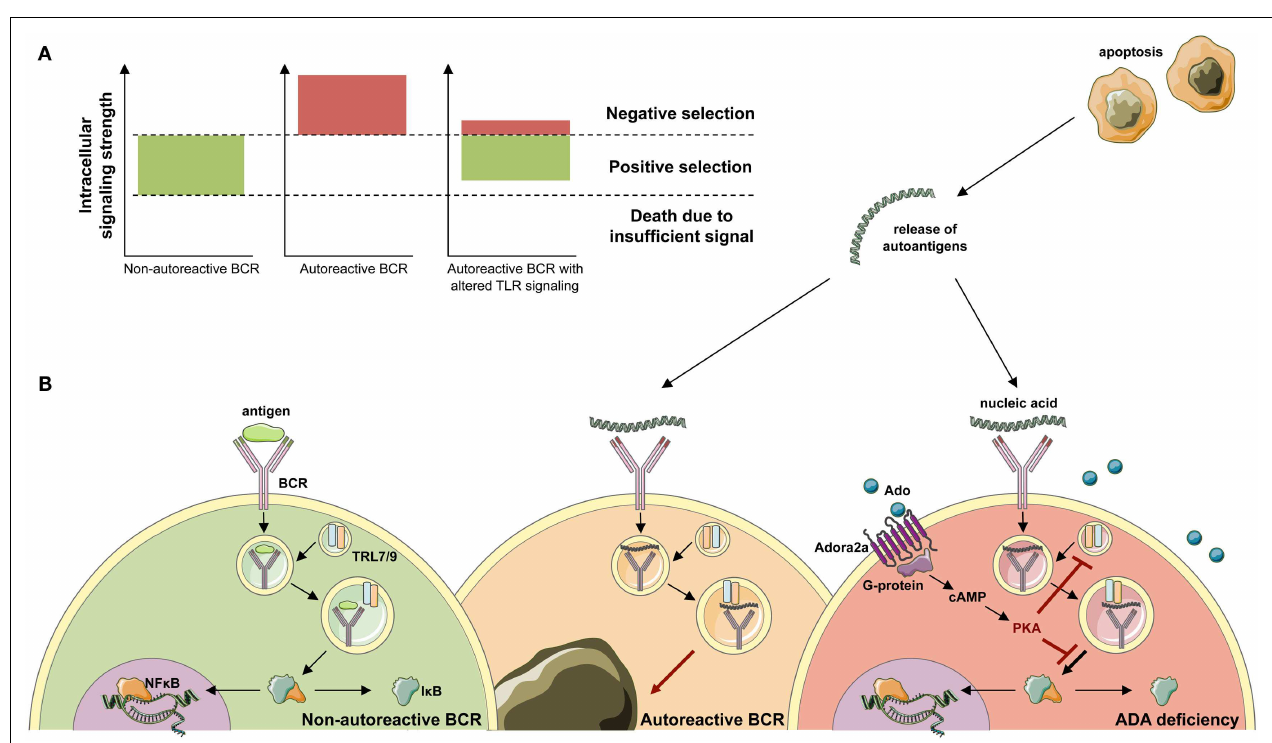
cell development and function. During the bone marrow differentiation of B cells, a major source of autoantigen is developing lymphocytes, which undergo apoptosis. Autoantigens are released in the extracellular space and form immune complexes. Binding of nucleic acid-containing immune complexes to an autoreactive BCR produces a strong activation signal through simultaneous activation ofTLRs and leads to the depletion or receptor editing of the B cell. It can be hypothesized that in ADA deficiency this negative selection is dampened by adenosine present in the extracellular place and engagement of the Adora2a. Activation of Adora2a elevates intracellular cAMP through activation of adenylyl cyclase. In turn, cAMP activates PKA that blocks the BCR-induced phosphorylation of I κ B to inhibit immunoreceptor-mediated NF- κ B activation in the cytoplasm.The strong depletion signal coming from BCR andTLR coengagement is thereby lowered and ADA-deficient B cells carrying an autoreactive BCR egress into the